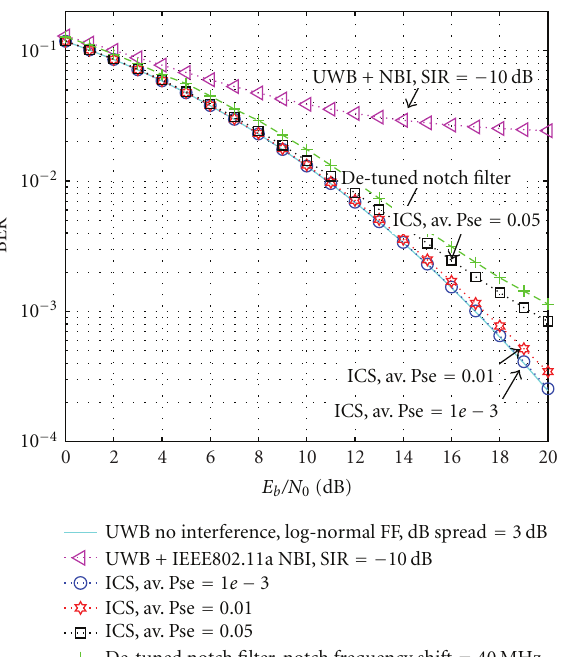
Figure 8: BER performance comparison of the ICS with a De-tuned Notch